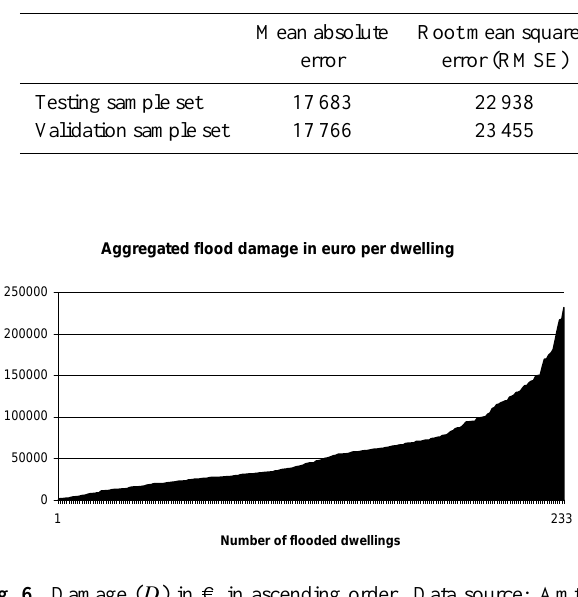
Table 6. Cross-validation results of the final model of Eq. (2).